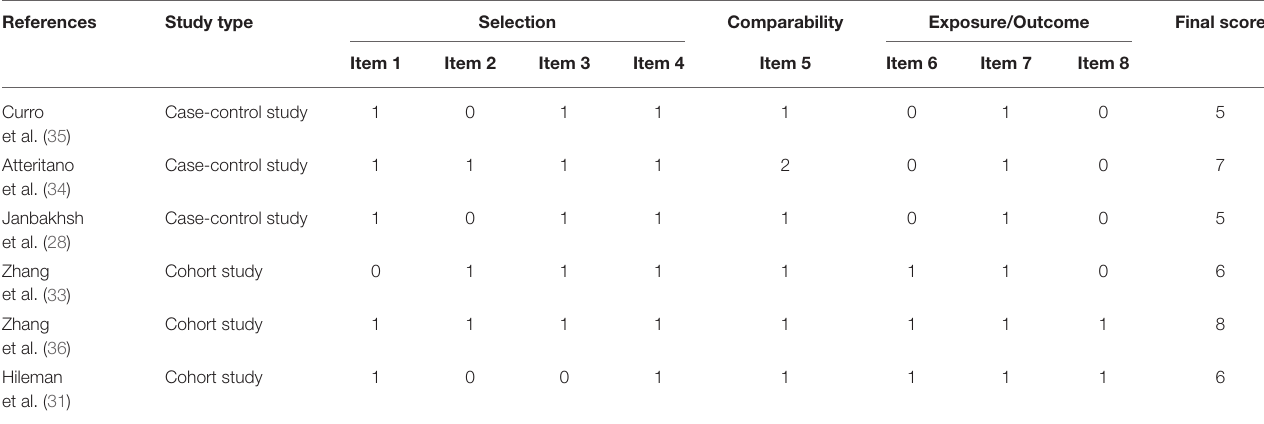
TABLE 3 | Quality assessment of included